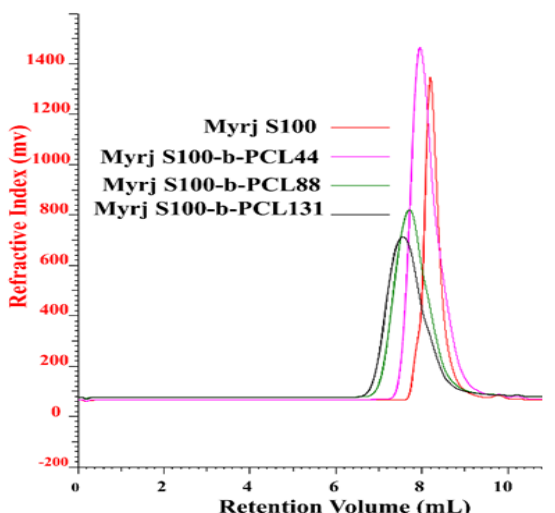
Figure 3. GPC chromatograms of unmodified Myrj S100 and the synthesized Myrj S100- b -PCL co- polymers.